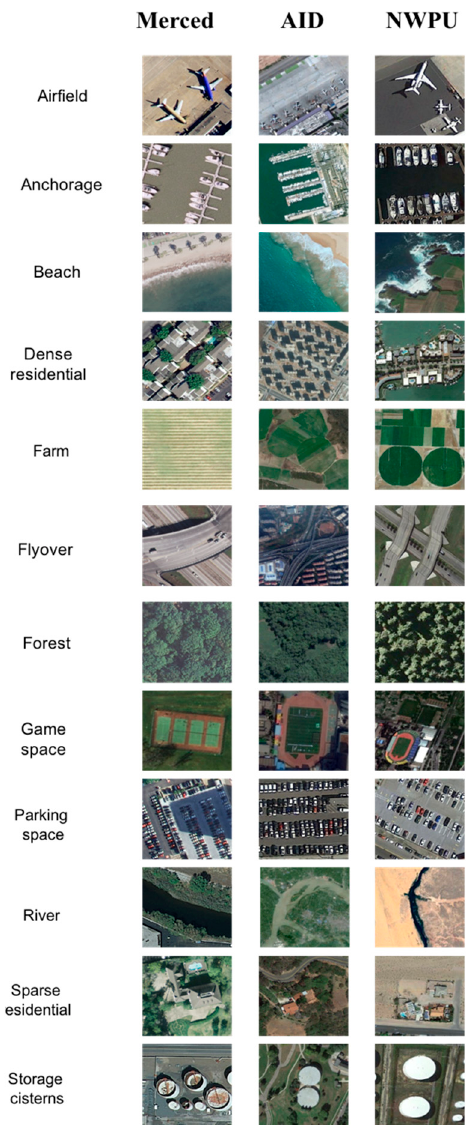
Figure 4. Example of samples from cross-scene dataset 1 composed of very high resolution (VHR) Figure